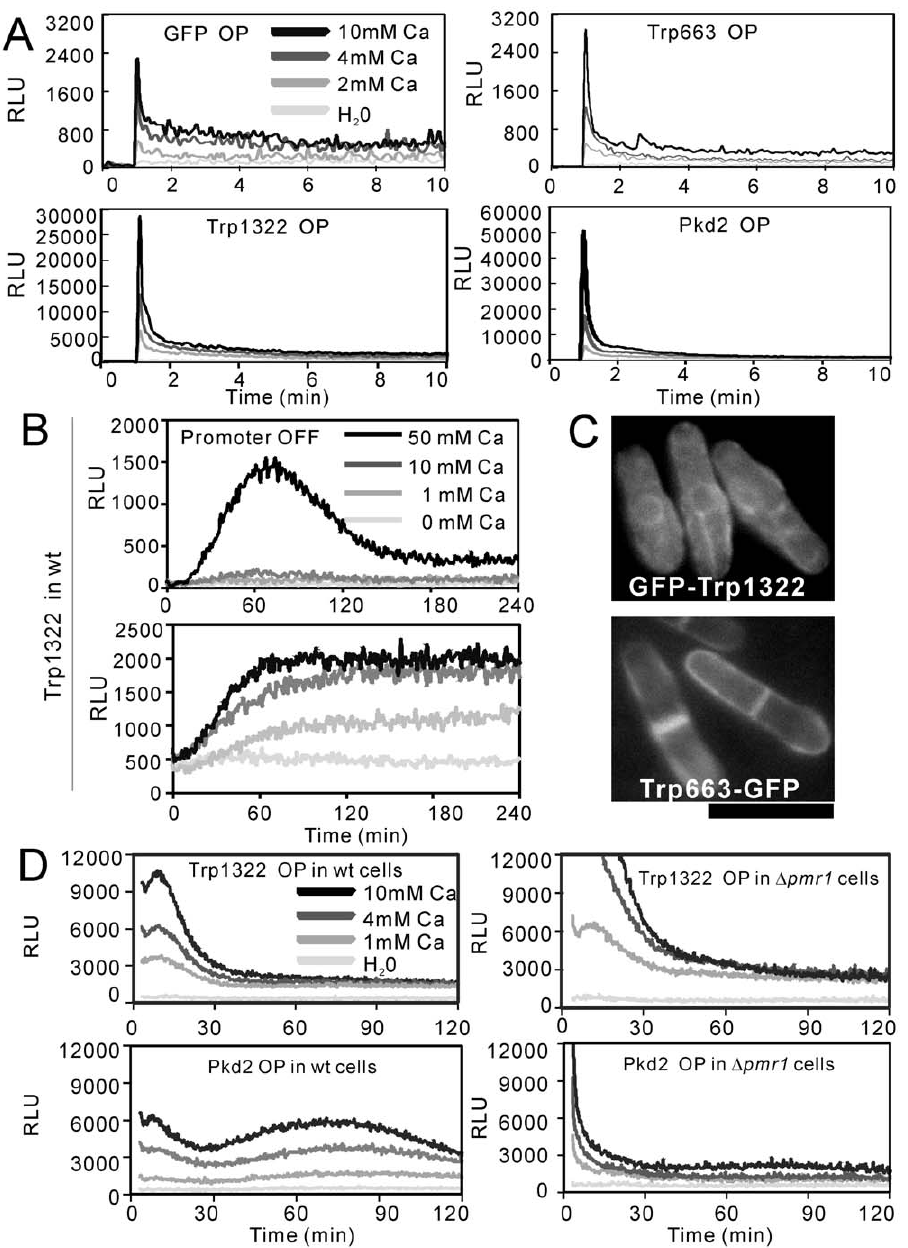
Figure 3. TRP channels play key roles in the regulation of cytoplasmic Ca 2 + in fission yeast. (A) The overexpression of trp1322 + and pkd2 + markedly enhanced the response to extracellularly added Ca 2 + . The KP3028 cells were transformed with a control vector, pREP1-GFP-Trp1322, or pREP1-Pkd2-GFP. The transformants were grown to exponential phase in the absence of thiamine for 36 hours to express GFP-19-AEQ, Trp1322 or Pkd2. The monitoring of the cytoplasmic Ca 2 + level was performed as described in Figure 2A. The data shown are representative of multiple experiments. (B) The CDRE-reporter activity in the cells overexpressing Trp1322. The KP2755 ( h 2 leu1 arg1 3 6 CDRE::luc(R2.2):: arg1 + ) cells were transformed with pREP1-GFP-Trp1322. The transformants were grown to exponential phase in the presence (Promoter OFF) or absence (Promoter ON, overexpression) of thiamine for 20 hours. The CDRE assay was performed as described in Materials and Methods. The data shown are representative of multiple experiments. (C) Intracellular localization of the two TRP channels. The wild-type cells harboring GFP-Trp1322 or Trp663- GFP were grown to early log phase in EMM containing 4 m M thiamine, and then were examined under the fluorescence microscope. Bar, 10 m m. (D) Pkd2 plays roles in inducing Ca 2 + release from the Golgi. The KP3028 or KP3025 cells were transformed with pREP1-GFP-Trp1322 or pREP1-Pkd2-GFP, then were cultured and assayed as described in Figure 2A.